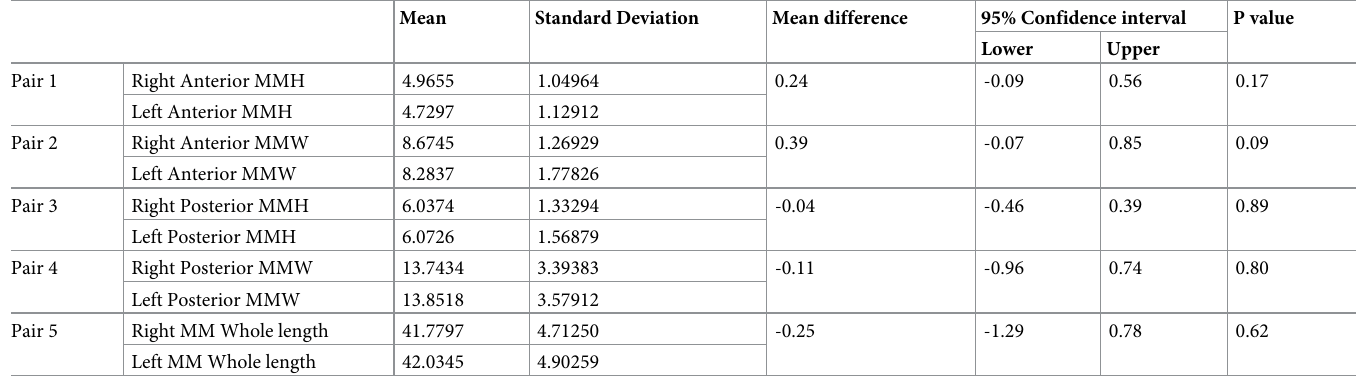
Table 2. Mean differences and the significance of the differences between the left and right knee meniscal measurements in the medial mid-sagittal view.